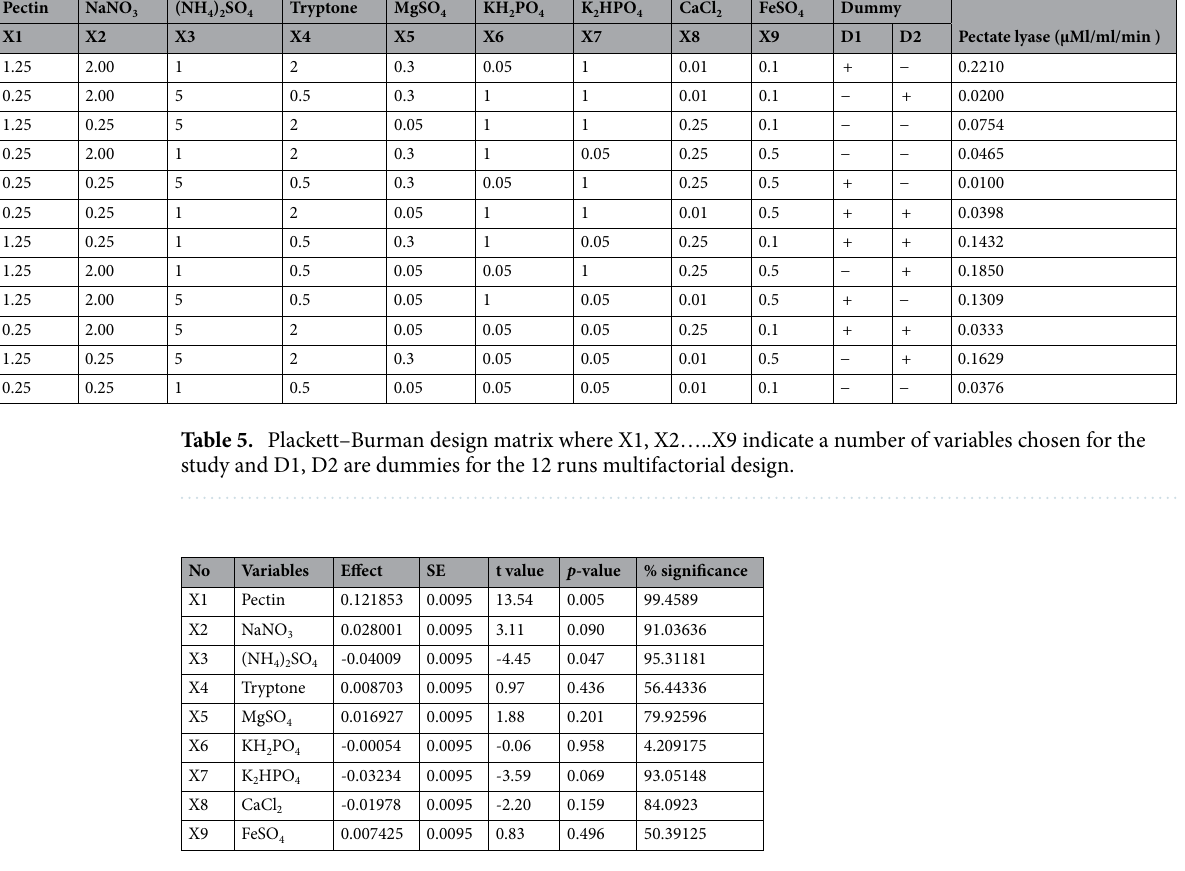
Table 6. Analysis of variance for Plackett–Burman design